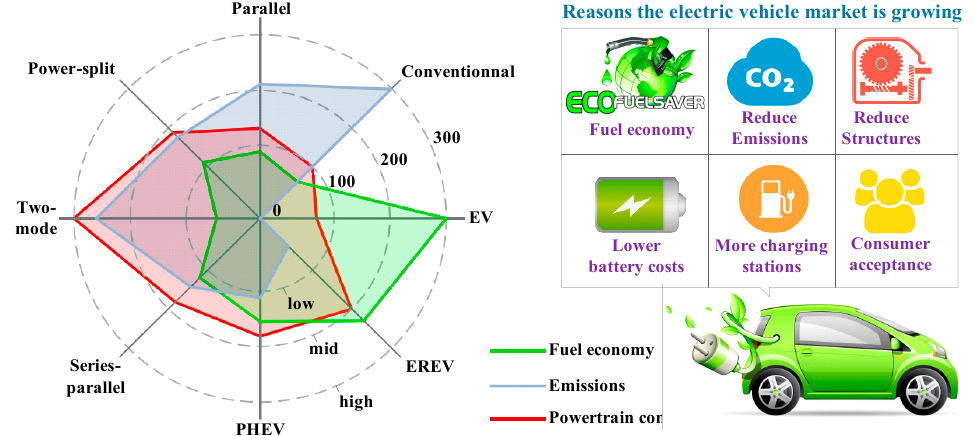
Figure 1. Powertrain comparisons and reasons why the electric vehicle (EV) market is growing. In 1998, Weiss [12] proposed an electric wheel drive for a utility vehicle that includes an output shaft with an electric motor that drives the final gear train to reduce the turning speed of the driven Energies 2018 , 11 , 2920;